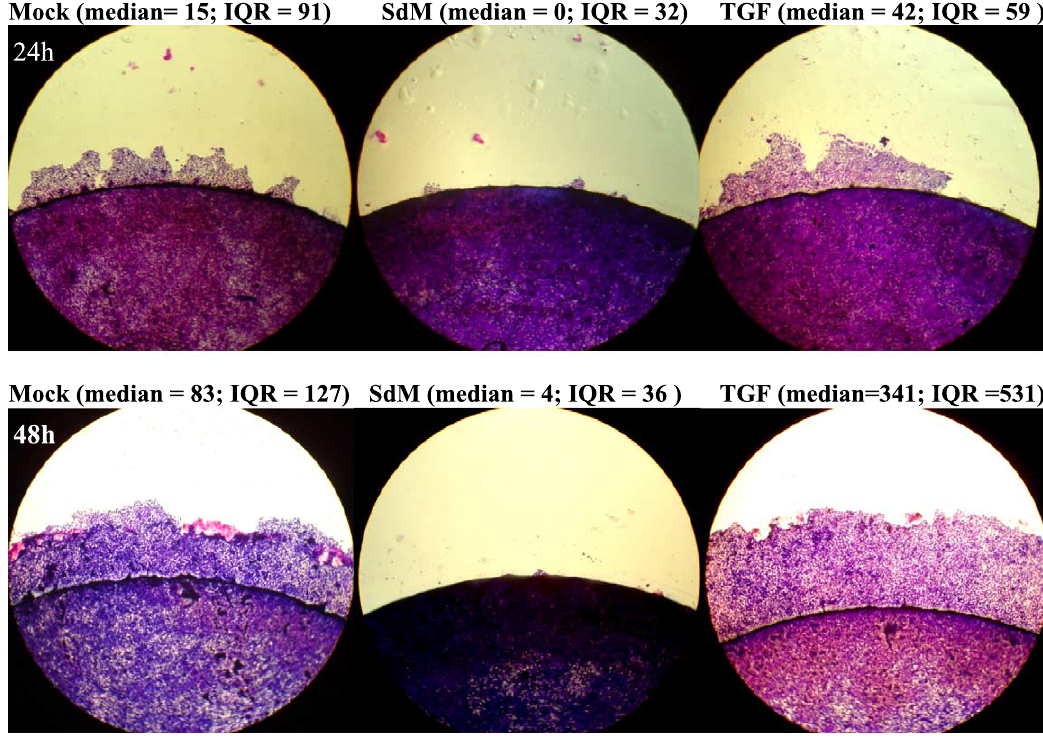
Fig. 6. Increased migration following TGF- β 1 treatment in the novel chemoattractant assay. A representative well from each treatment group is shown. The brackets contain the median number of boxes covered by AY-27 cells migrating across the gap for each treatment group and the Interquartile range (IQR). (The colors are visible in the online version of the